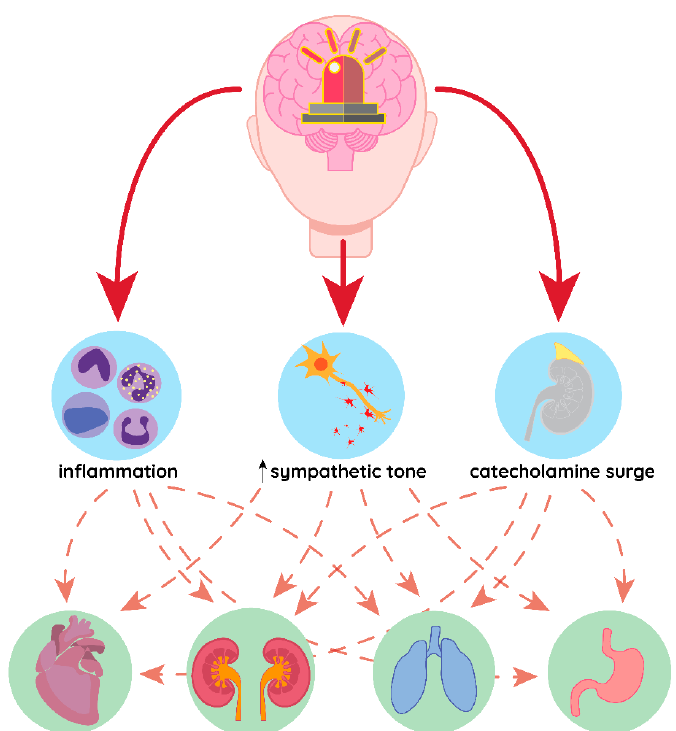
Figure 1. Common pathomechanism of distant organ damage in acute brain conditions. Inflammation, increased sympathetic tone and catecholamine surge in response to brain injury may a ff ect di ff erent organs simultaneously, leading to their